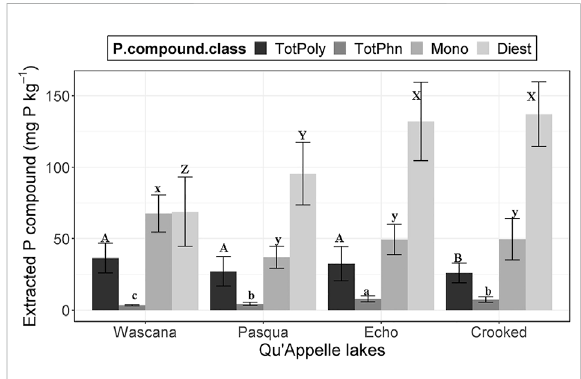
FIGURE 5 Concentrations of P compound classes (mg P kg − 1 dry weight) in NaOH-EDTA extracts of sediments analyzed by P-NMR spectroscopy. Values are means (±SD); n = 14 (7 depths, duplicate cores). The bar plots show TotPoly, total polyphosphates; TotPhn, total phosphonates; Mono, total orthophosphate monoesters; and Diest, total orthophosphate diesters corrected for degradation during analysis on the y -axis and the sampled Qu ’ Appelle lakes are on the x -axis. Different groups of capital and common letters for each P compound indicate signi fi cant ( p < 0.05) differences in P compound class concentrations among lakes, determined by two-way ANOVAs followed by Tukey HSD post-hoc